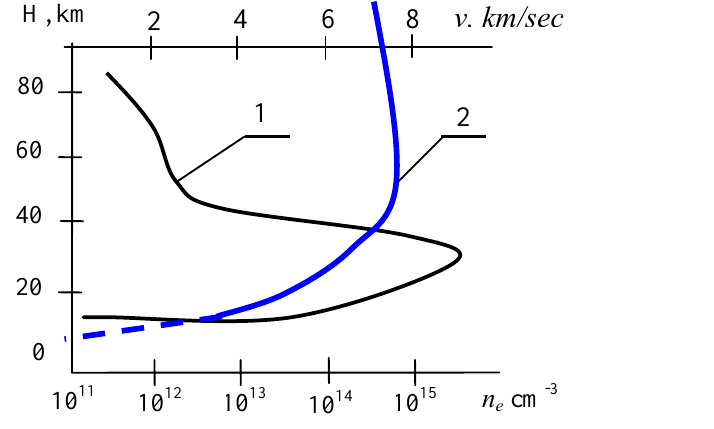
Figure 3 – Electron concentration of the double electric layer (1) and the flight velocity (2), depending on the altitude of the satellite's descent at the first cosmic velocity Рис . 3 – Концентрация электронов двойного электрического слоя (1) и скорость полета (2) в зависимости от высоты снижения спутника при первой космической